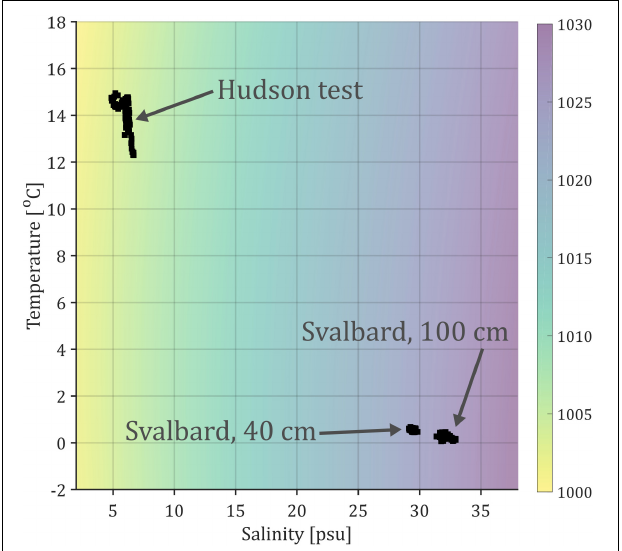
FIGURE 13 | T-S (temperature-salinity) plot showing data from three separate DD µ D-obtained sources: a test in the Hudson River and two in Svalbard at 40 cm and 100 cm depth. The background is colored according to water density in kg m − 3